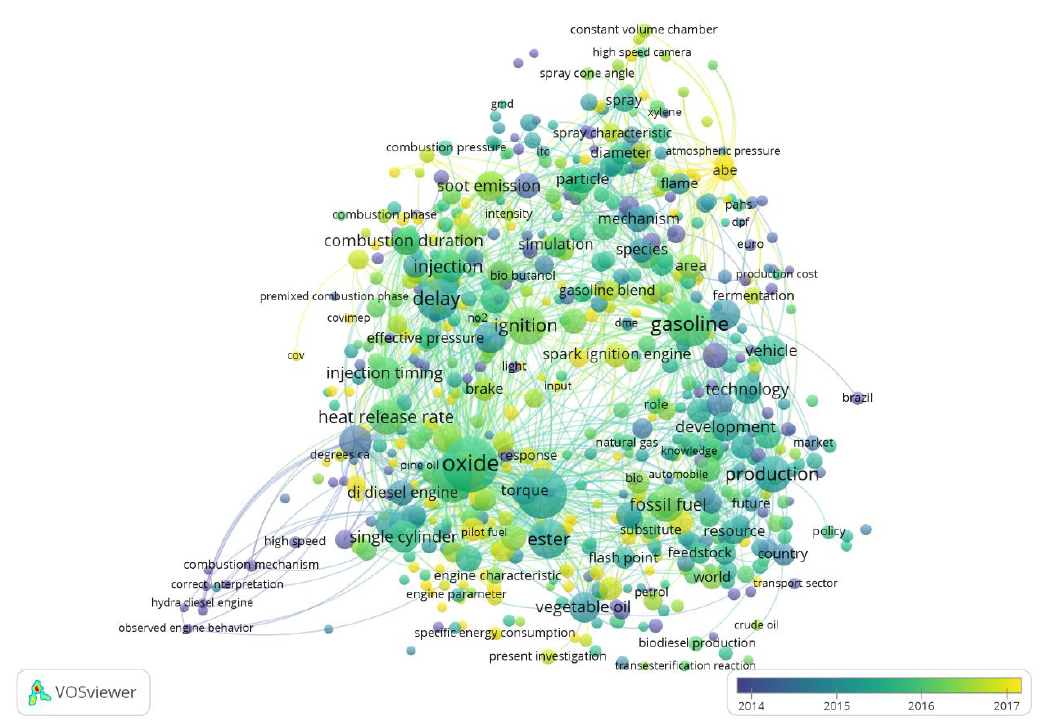
Processes 2021 , 9 , x FOR PEER REVIEW Figure 3. Research topics provided by Web of Science, Clarivate, including ethanol/diesel fuel blends.